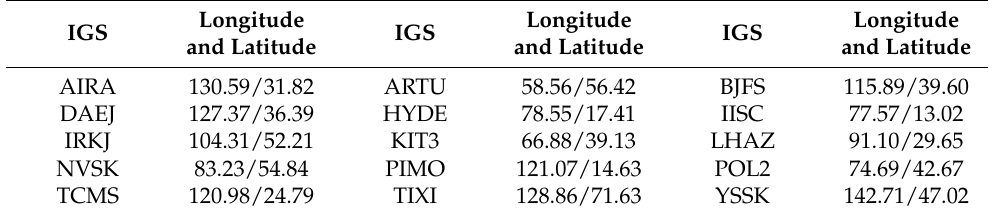
Table 1. The 15 IGS sites used for the calculation of the CORS network in Western Yunnan Province.